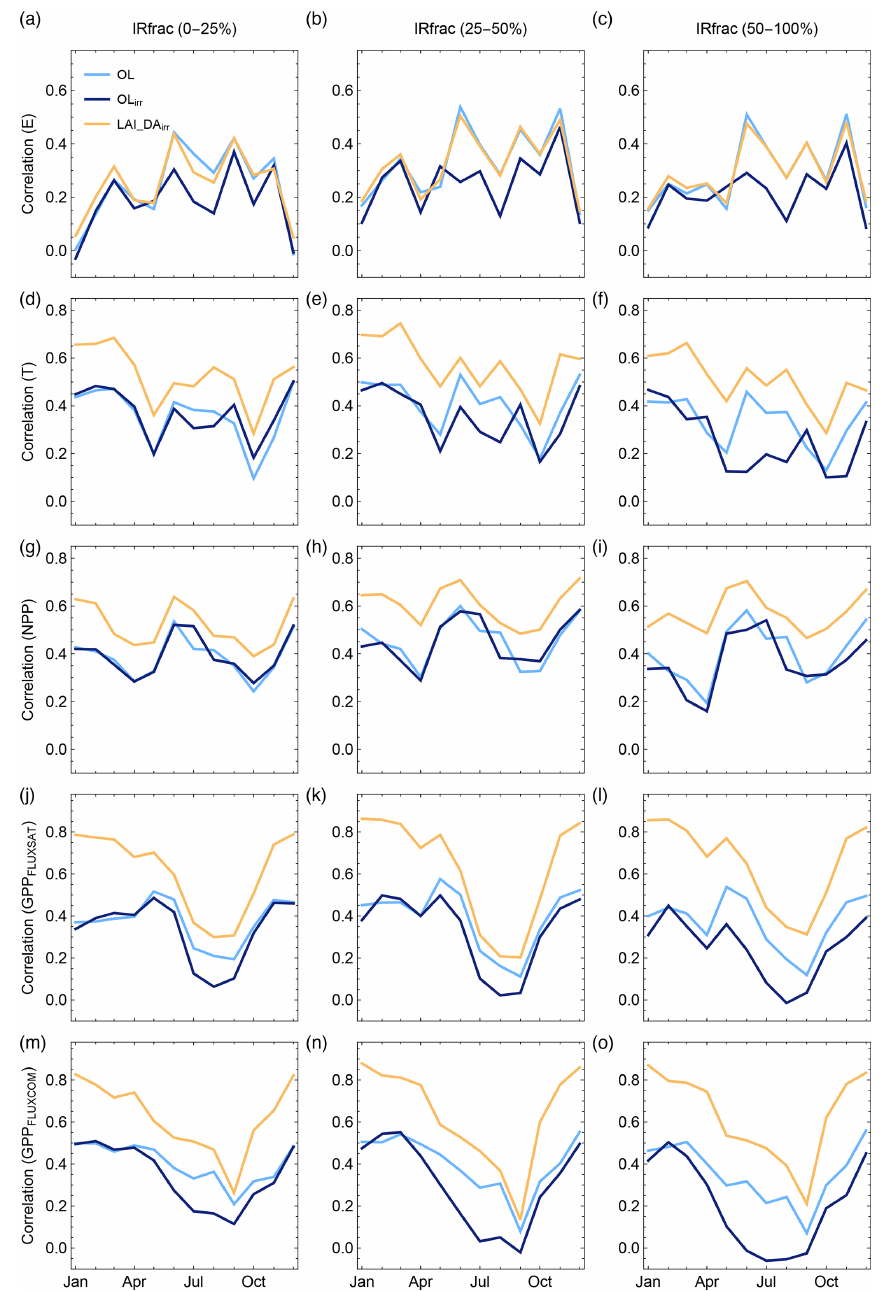
Figure 7. Interannual correlation of evaporation ( E ) and transpiration ( T ), net primary production (NPP), and gross primary produc- tion (GPP) averaged over actively irrigated areas with low (a, d, g, j, m) , moderate (b, e, h, k, n) , and high (c, f, i, l, o) irrigation fraction intensities for the OL, OL irr , and LAI-DA irr